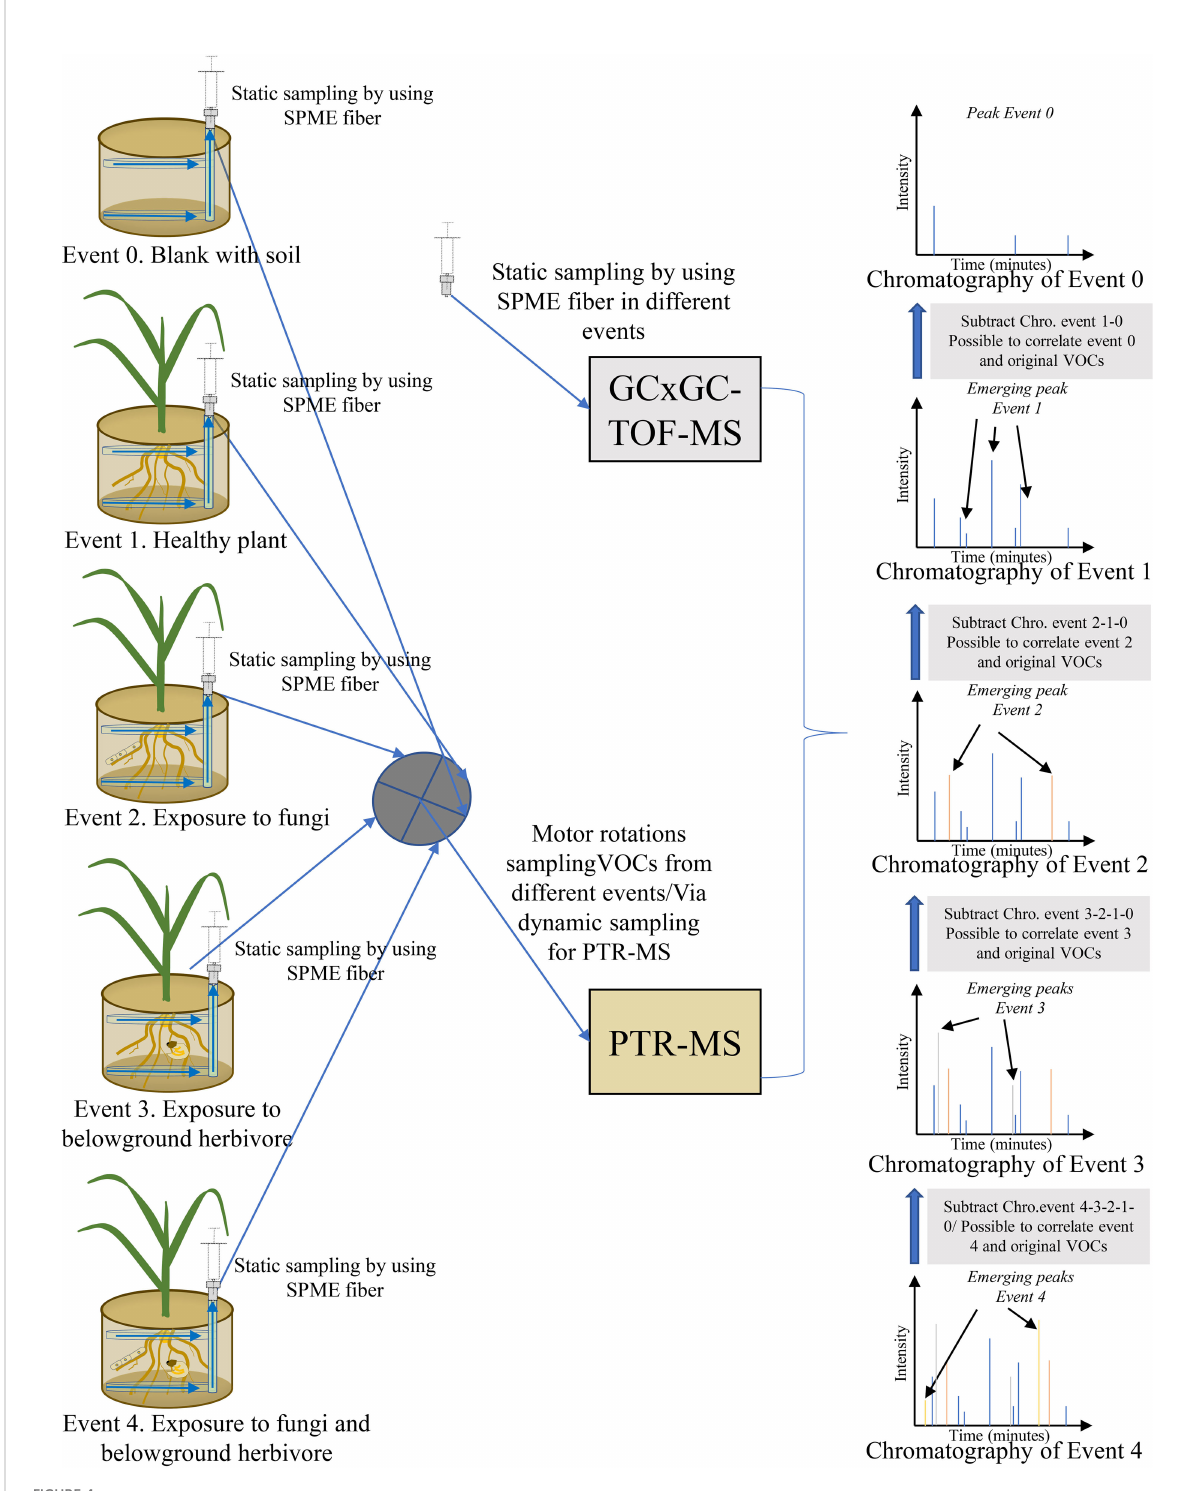
FIGURE 4 Schematic illustration of an in-situ design to collect and analyze belowground volatile organic compounds (VOCs) by a combined technique. Original VOCs are distinguished by subtracting chromatographic peaks of certain